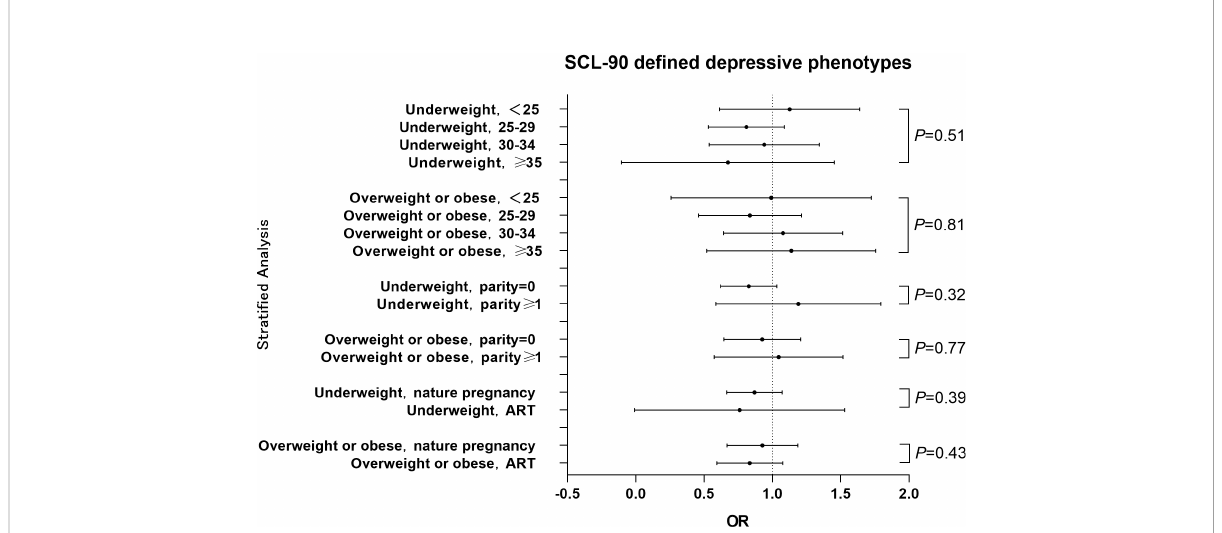
FIGURE 3 Hierarchical analysis of the association between pre-pregnancy BMI and SCL-90 estimated depressive phenotypes among different stratums of age, parity history or way of conception The OR value for each stratum was calculated with comparison to the women with normal BMI. Pint refers to P for